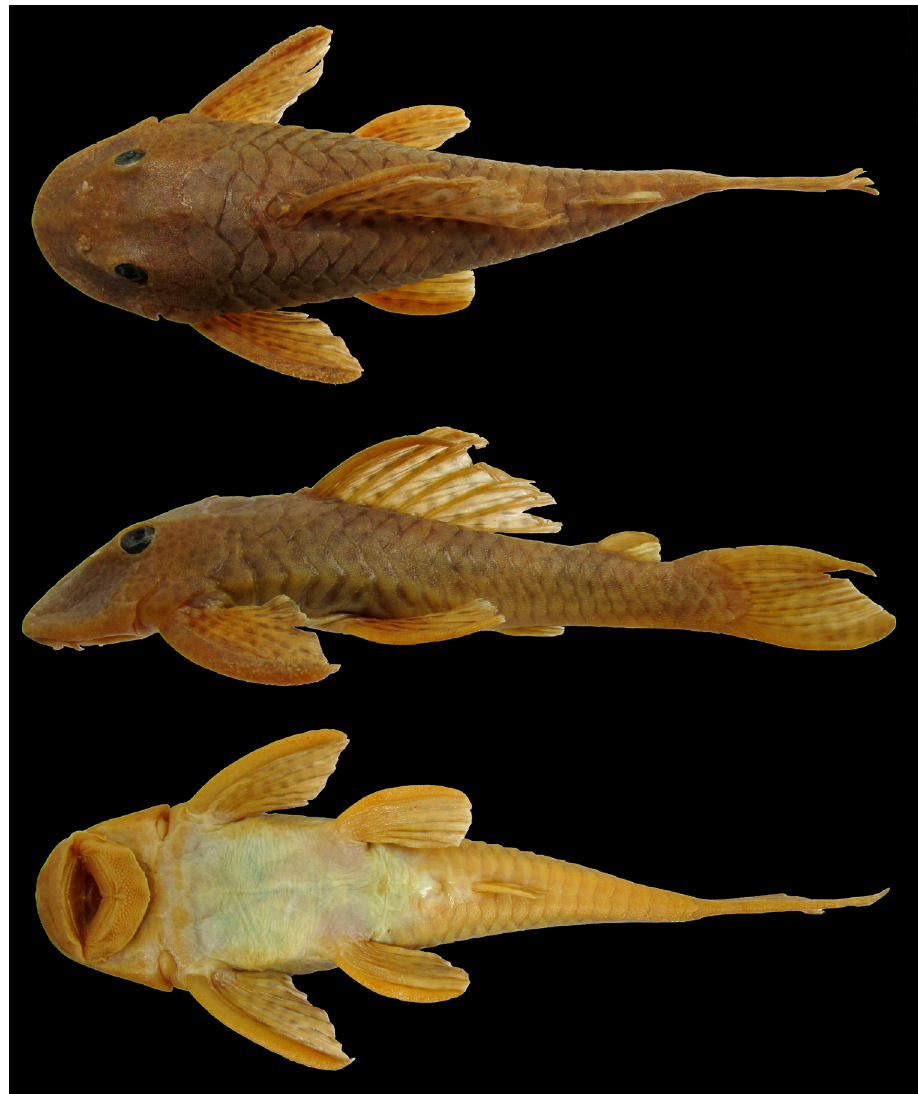
FIGURE 3 | Hypostomus velhomonge , UFPB 9565, holotype, 118.0 mm SL, rio Balsas, tributary of Parnaíba River, Maranhão State,